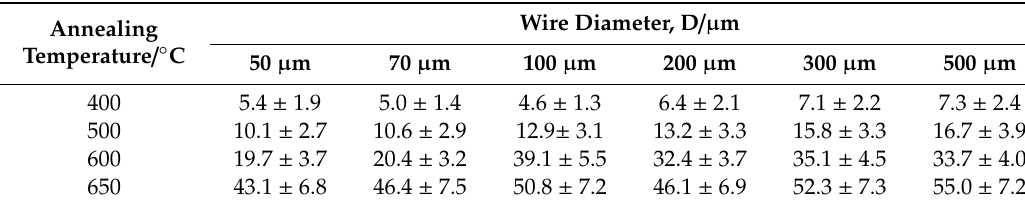
Table 1. Average grain size after